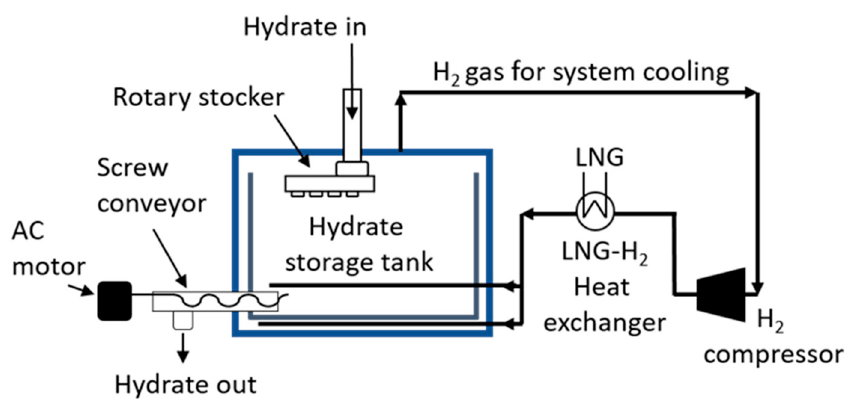
Figure 12. Schematic of hydrogen-hydrate storage facilities composed of a cylindrical, above-ground storage tank and a refrigeration system with hydrogen.